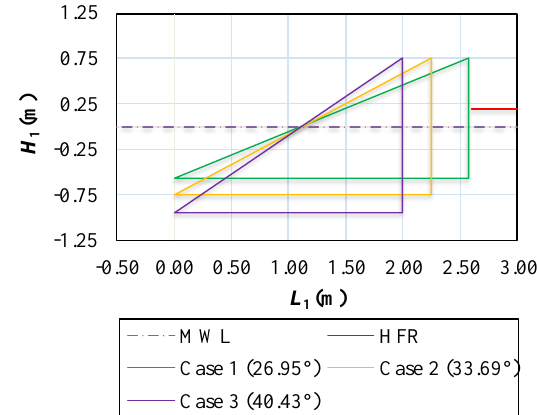
Figure 14. Geometries for the one ramp OTD-WEC.